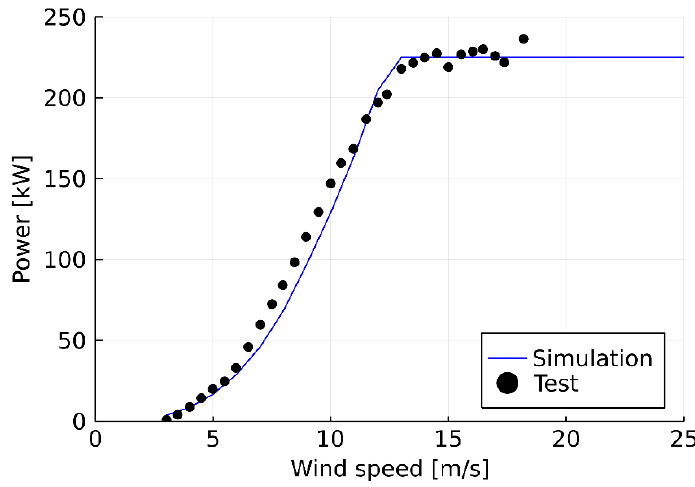
Figure 3. Power curve comparison between the simulated data and the testing results.